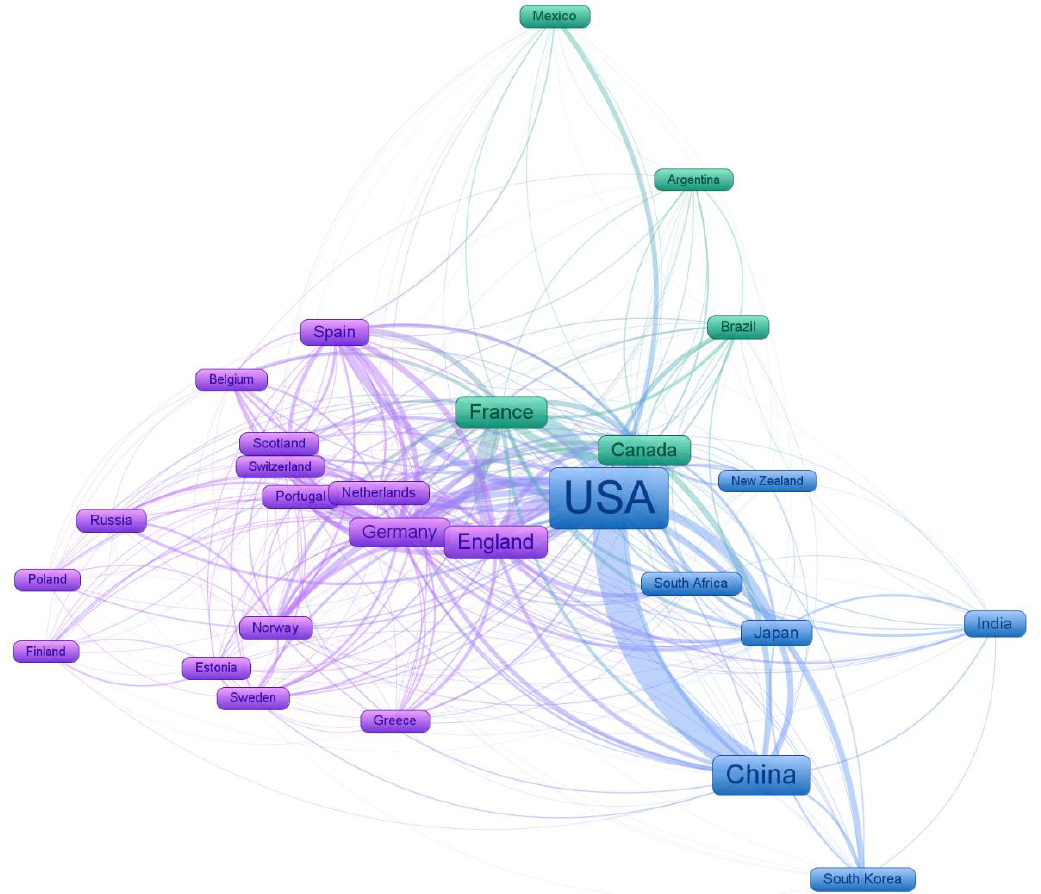
Figure 3. Cooperation between countries (the same color in the figure indicates the most closely related cooperation group; the size of the box indicates the number of national papers, with a larger box indicating more papers; and a connection between countries indicates the intensity of cooperation, with a thicker connection indicating a closer cooperative relationship).